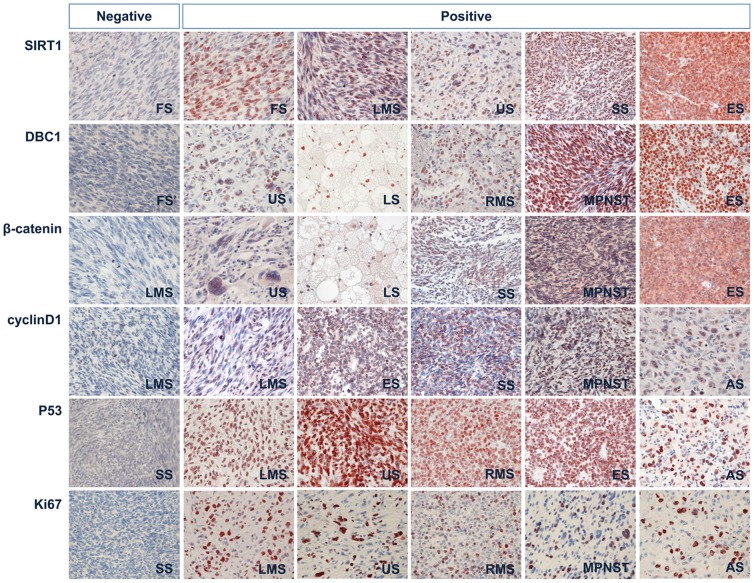
Immunohistochemical expression of SIRT1, DBC1, β-catenin, cyclin D1, P53, and Ki67 in various soft tissue sarcomas.All markers are expressed primarily in the nuclei of the tumor cells. Abbreviations: FS, adult fibrosarcoma; LMS, leiomyosarcoma; US, undifferentiated sarcoma; SS, synovial sarcoma; ES, Ewing sarcoma; LS, liposarcoma; RMS, rhabdomyosarcoma; MPNST, malignant peripheral nerve sheath tumor; AS, angiosarcoma. Original magnification, x400.